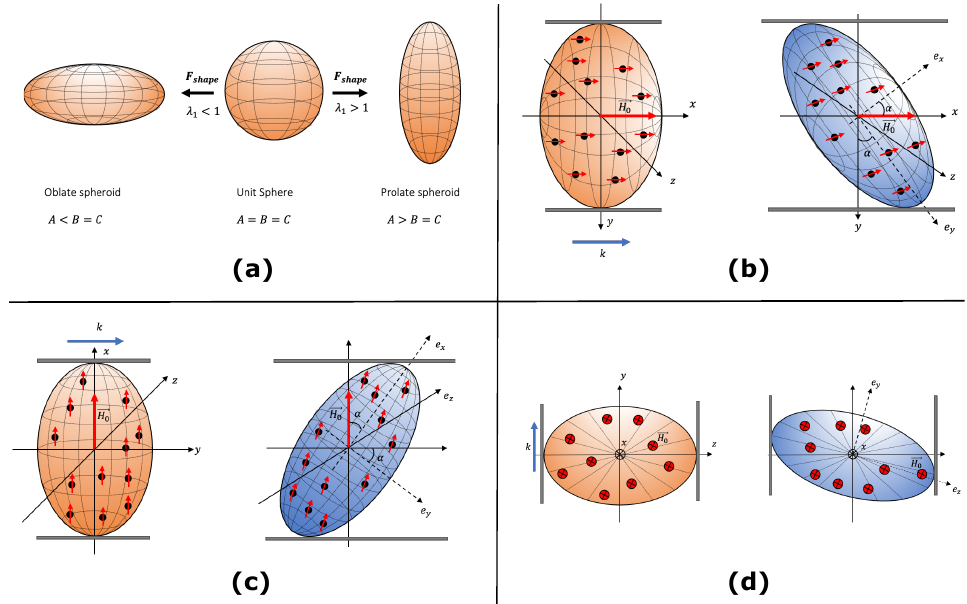
Figure 3. The shape transformation and shear geometries: ( a ) The transformation of a unit sphere to an ellipsoid of revolution with two equal semi-axes. ( b ) Schematics of shear deformation of an oblate MAE along the field direction. The displacement k is applied to the bottom plate in the x -direction. ( c ) Schematics of the shear deformation of a prolate MAE perpendicular to the field direction. The shear displacement k is applied to the top plate in the y -direction. ( d ) Schematics of shear deformation of an oblate MAE in the y - z plane which is perpendicular to the field direction. The circle with a cross represents the x -direction. The shear displacement k is applied to the left plate along the y